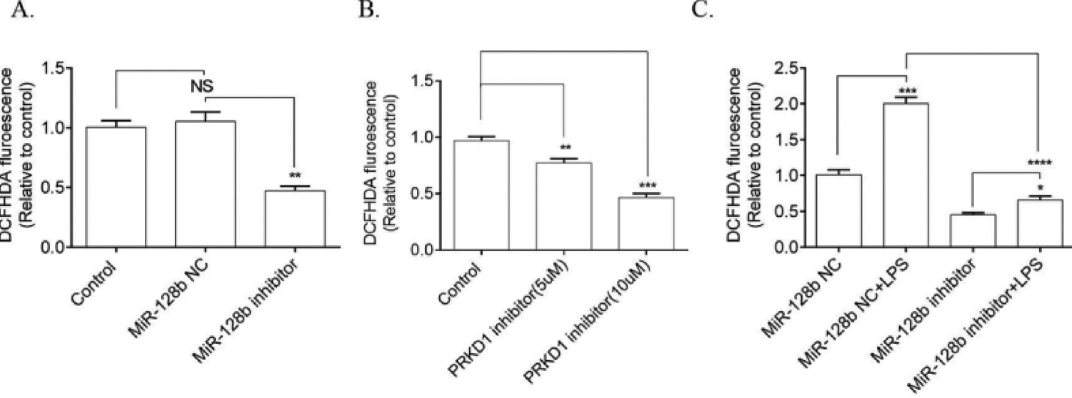
Figure 4. (C) Reactive Oxygen Species (ROS) production via FCM analysis using 2,7-Dichloro fl uorescein Diacetate (DCFHDA). ROS production in Human Pulmonary Microvascular Endothelial Cells (HPMECs) was evaluated after 24h of transfection with an miR-128b inhibitor (50 nM), NC (10 nM), or CRT0066101 (5 μ M, 10 μ M) and after 24 h treatment with Lipopolysaccharide (LPS) (1 μ g/mL) ( n = 4). Data are represented as mean ± SEM. * p < 0.05, ** p < 0.01, *** p < 0.001, **** p < 0.0001.